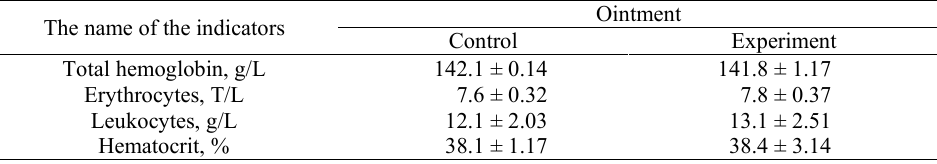
Indicators of the morphological state of the blood of white rats after 14-day application of the ointment on the skin (M ± m, n = 5)